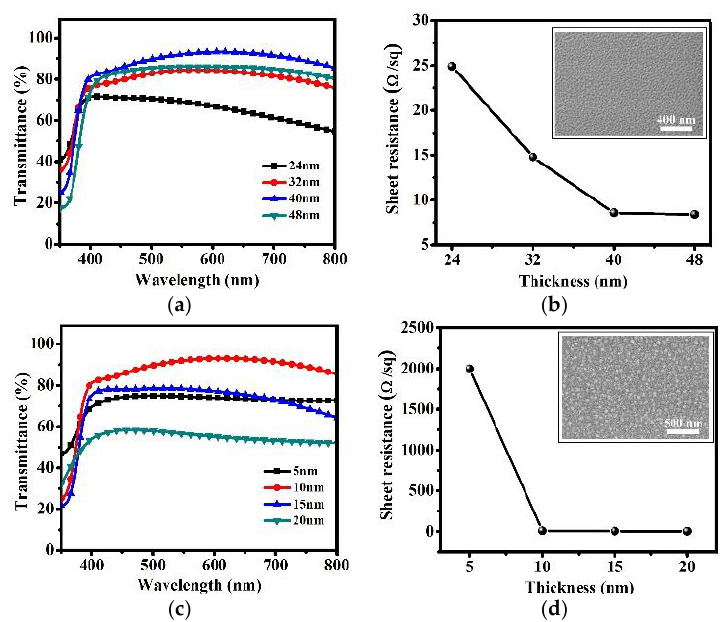
Figure 4. Properties of ZnO/Ag/ZnO multilayer for different ZnO thicknesses: ( a ) optical transmittance spectra; and ( b ) conductivity. Properties of ZnO/Ag/ZnO multilayers for different Ag thicknesses: ( c ) optical transmittance spectra; and ( d ) conductivity.